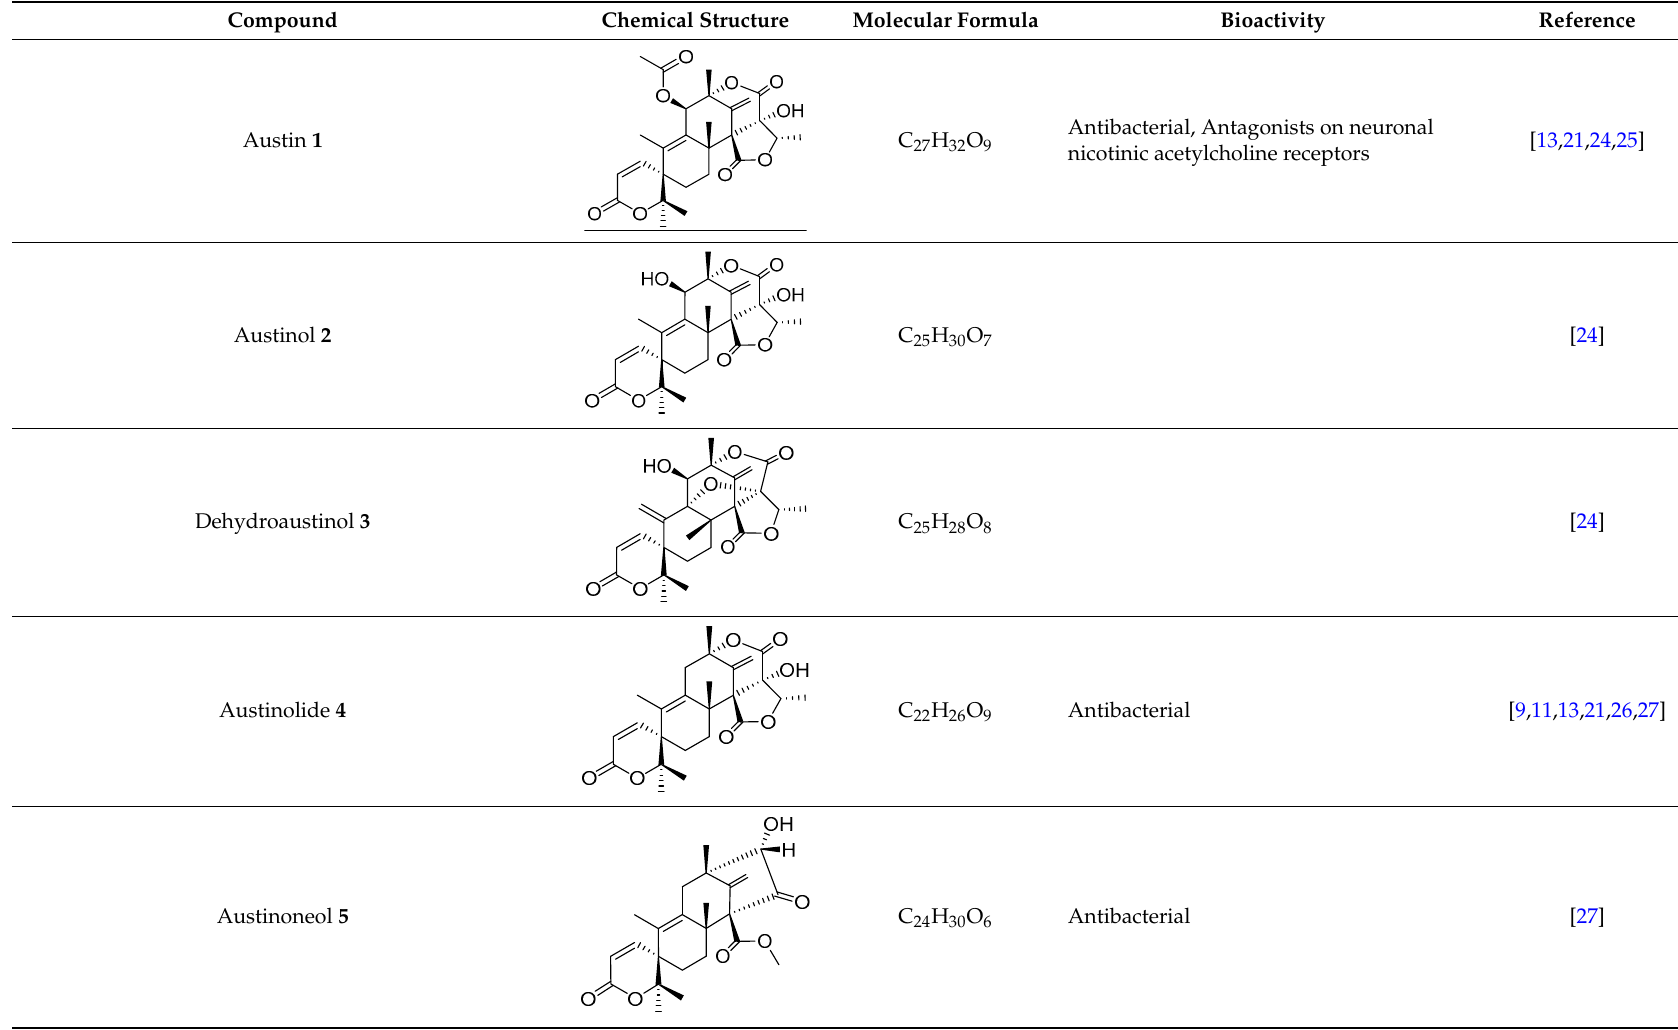
Table 1. Secondary metabolites produced by Penicillium brasilianum .